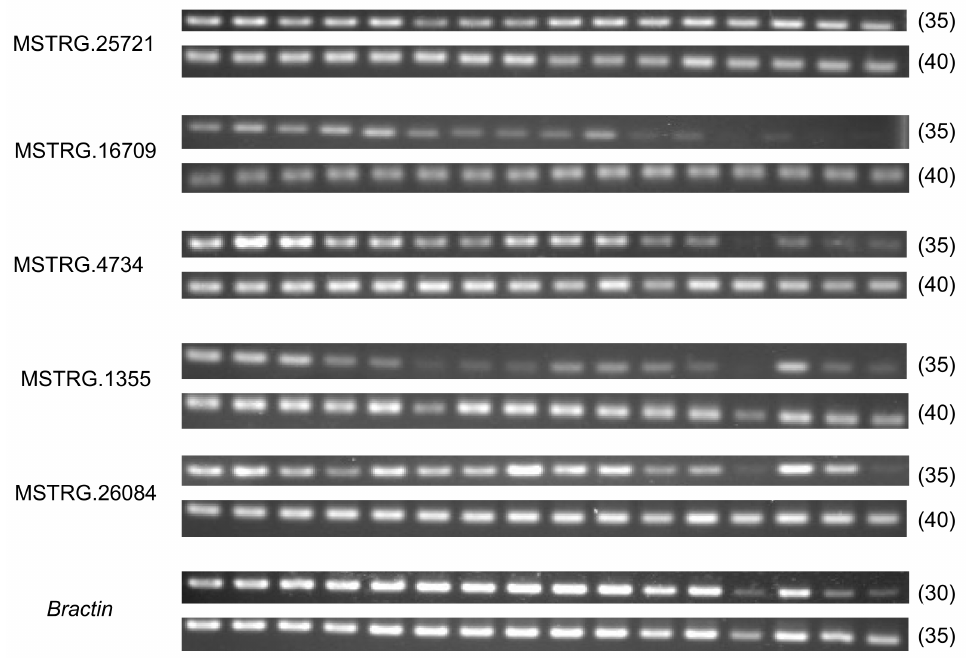
Figure 8. RT-PCR of NATs in sixteen B. rapa lines. The number in parentheses (30, 35, or 40) represents the number of PCR cycles. The number represents each line as follows: For Chinese cabbage lines (var. pekinensis ), 1 = RJKB-T39, 2 = RJKB-T41, 3 = RJKB-T42, 4 = RJKB-T43. For komatsuna lines (var. perviridis ), 5 = ‘Inasena’, 6 = ‘Nacchan’, 7 = ‘Nanane’, 8 = ‘Wakami’. For pak choi lines (var. chinensis ), 9 = ‘Kunyan’, 10 = ‘Natsu-Mikado’, 11 = ‘Niihao-syan’, 12 = ‘Raiko’. For turnip lines (var. rapa ), 13 = ‘Mifune’, 14 = ‘Nitou’, 15 = ‘Shiro-Warabe’, 16 =